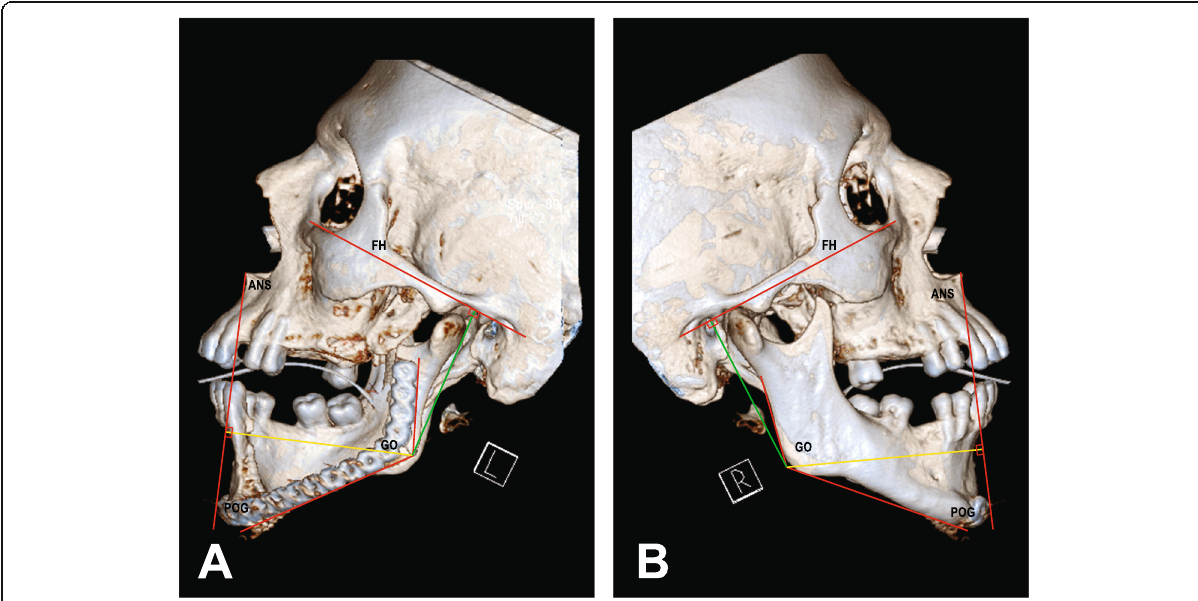
Fig. 2 The bilateral distances of the GO point to the Frankfurt line and a line passing through the ANS and Pog were measured to assess its position in superior-inferior (green line) and anterior-posterior (yellow line) dimensions in 3D-CT (sagittal view) for a reconstruction cases and b normal control group cases